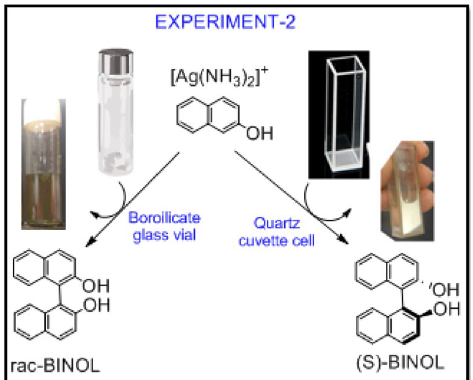
Figure 4. Role of silver film formation on the surface of the reaction vessel (-is this a chirality induction?): Reaction of [Ag(NH